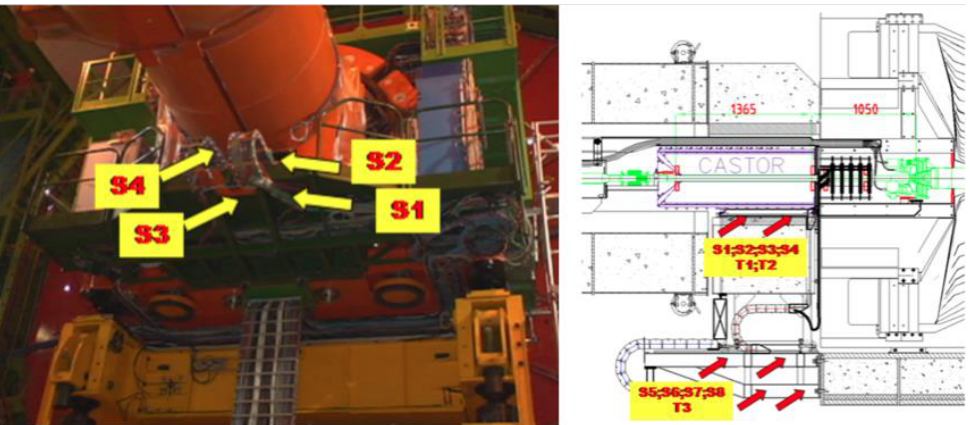
Figure 23. Layout of the FBG-based monitoring system installed on the CASTOR platform structure.